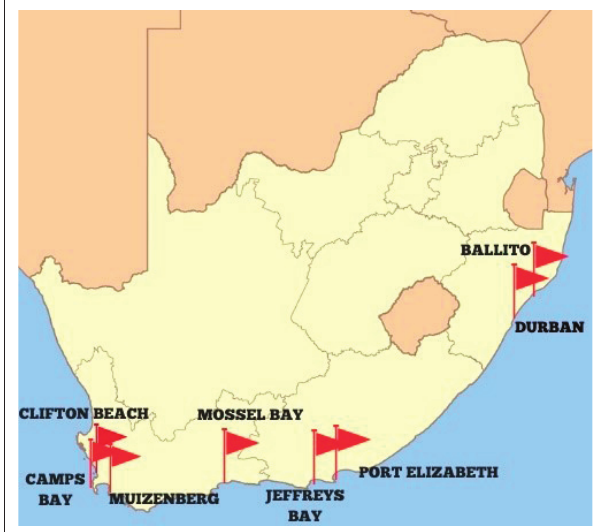
FIGURE 2: Map indication location of